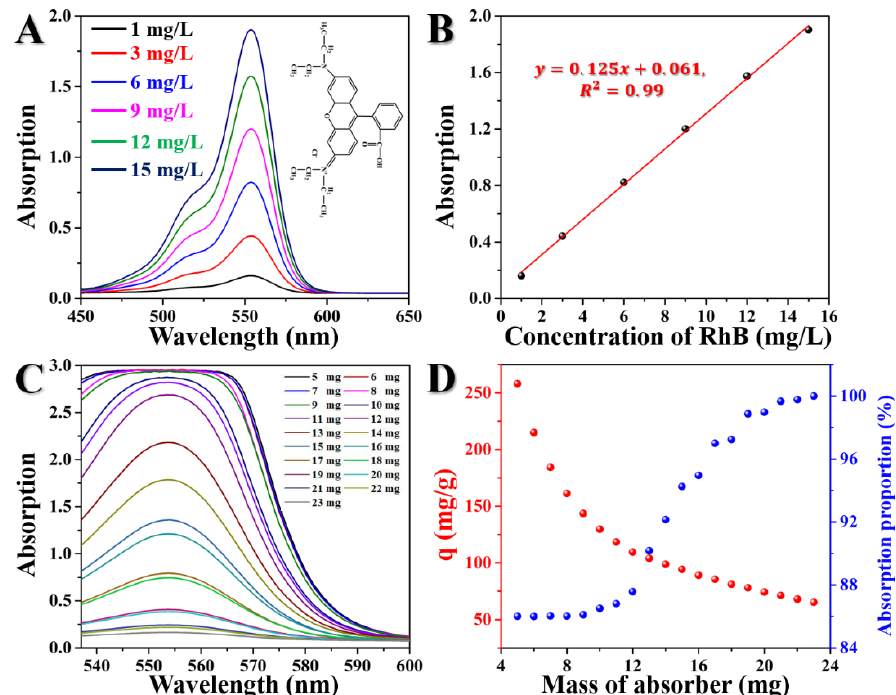
Figure 5. ( A ) The UV-vis spectroscopy adsorption results of RhB solutions with concentrations of 1, 3, 6, 9, 12, and 15 mg / L and the inserted RhB molecular structure. ( B ) The plots and corresponding fitting curve of the optical density of RhB solution at 554 nm vs concentrations. ( C ) The UV-vis spectroscopy adsorption results of RhB solutions treated with di ff erent dosages of magnetic carbon foam. ( D ) The removal proportion and the adsorption capacity of magnetic carbon